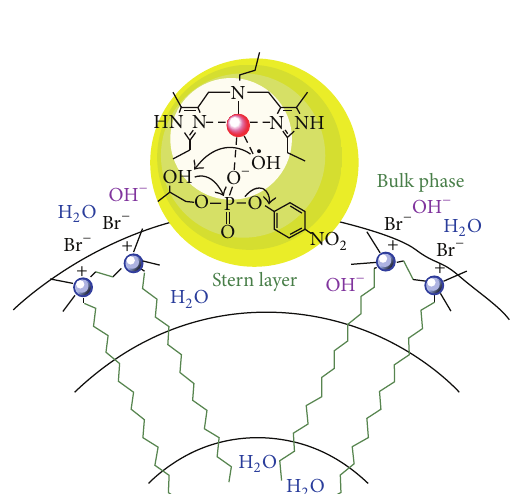
Figure 6: Catalytic cleavage of 2-hydroxypropyl p -nitrophenyl phosphate by Zn(II) complex in the Stern layer of gemini 16-2-16 micelles